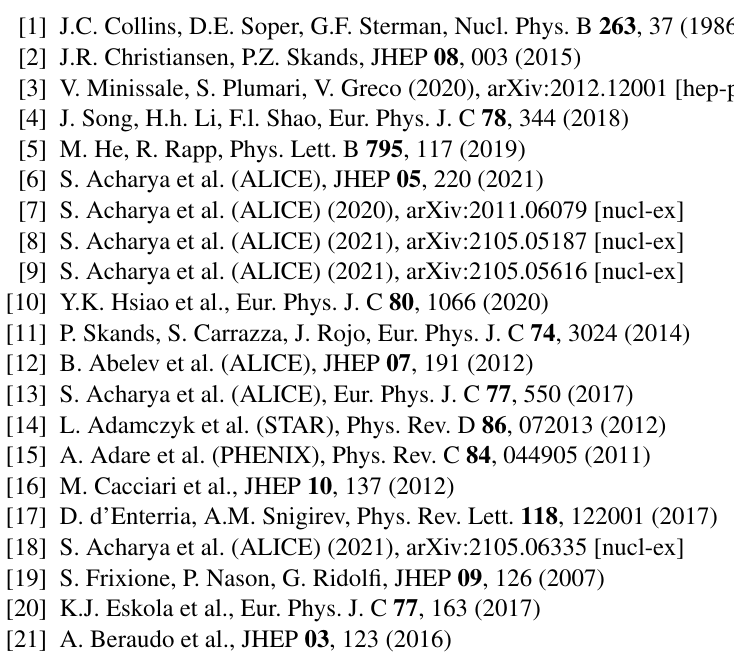
baryon as a function of p T in p–Pb c